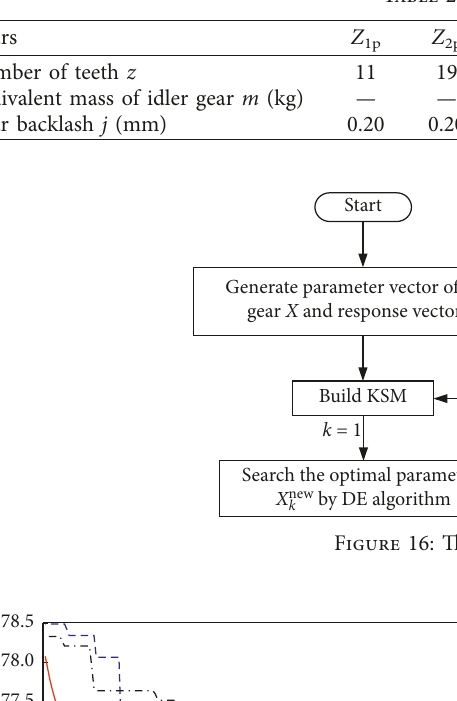
Table 2: Structural parameter of each gear.